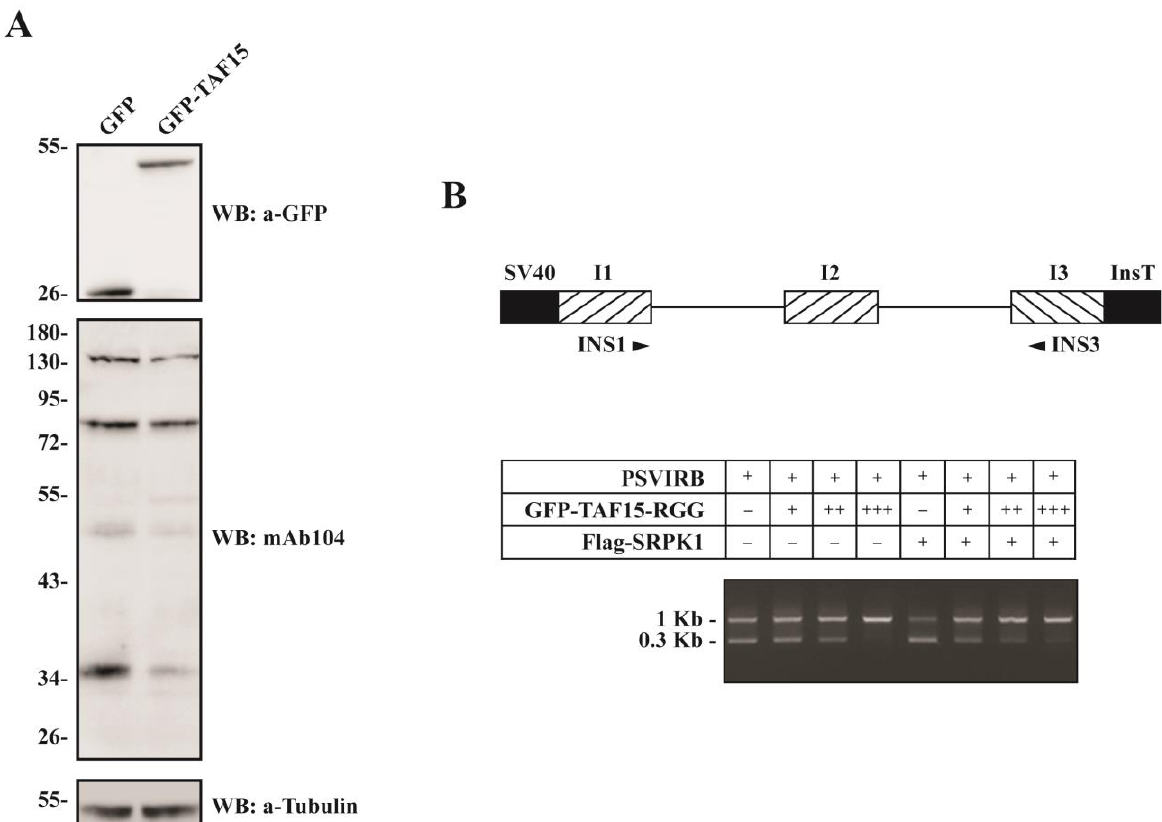
Figure 6. Overexpression of TAF15-RGG results in reduced SR protein phosphorylation and alters the splicing of a reporter minigene. ( A ) mAb104 analysis of the phosphorylation state of SR proteins from HeLa cells transfected with GFP or GFP-TAF15-RGG. The expression levels of GFP and GFP-TAF15-RGG are shown in the upper panel, while immunoblotting with a mouse monoclonal anti-tubulin antibody was used as a loading control (lower panel). Numbers on the left indicate molecular masses (in kDa). ( B , upper panel) Schematic representation of the insulin expression construct. SV40 promoter/enhancer and transcription terminator regions are shown in black, exons (I1, I2, and I3) are diagonally striped, and introns are indicated as lines. The primers used for PCR are indicated by arrows. ( B , lower panel) HeLa cells were transfected with 1.2 μg of the reporter gene along with increasing concentrations (0.4, 0.8, and 1.2 μg) of pEGFP -C1-TAF15-RGG (indicated as +, ++, and +++, respectively) without (first four lanes) or with (last four lanes) co-transfecting 0.4 μg of plasmid encoding FLAG-SRPK1. RNA was isolated 24 h later, and RT-PCR was carried out. The sizes of the spliced and unspliced products are 290 bp and ~1kb,